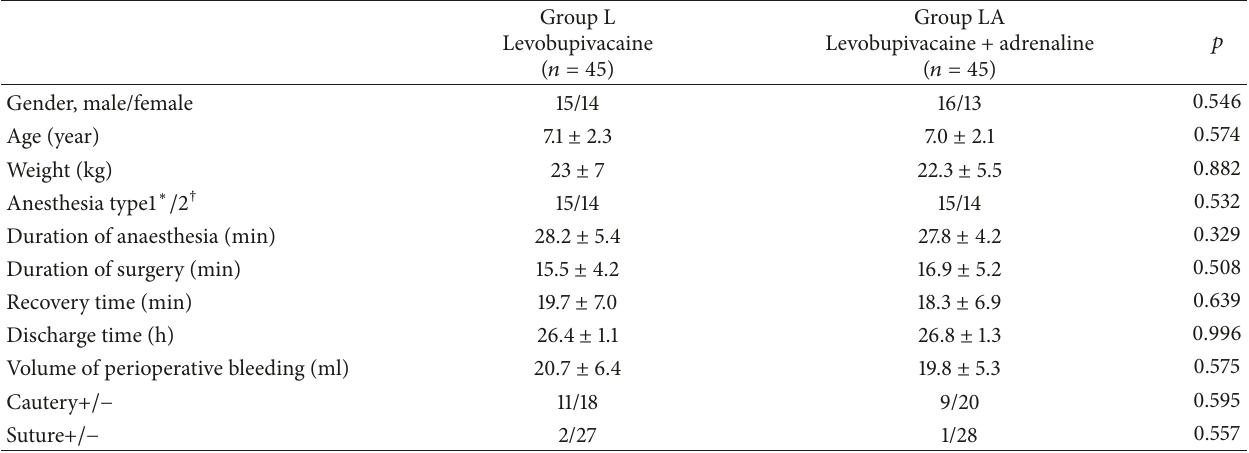
Table 1: The demographic and operative data and comparative variables between the two groups and values given are mean ± st.